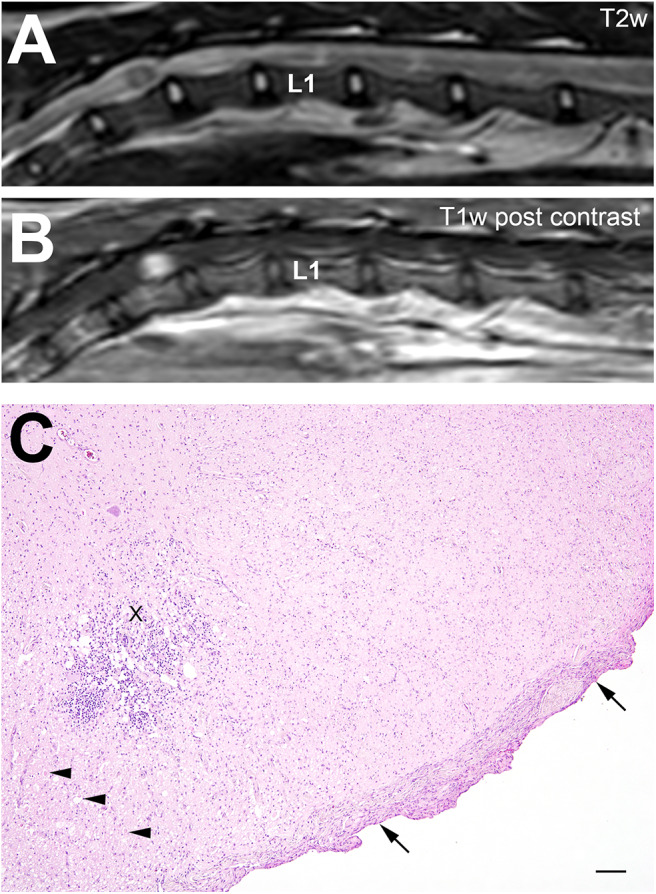
Cat no. 4. (A,B) Magnetic resonance imaging (MRI): Midsagittal section of the spinal cord at the thoracolumbar junction in T2w (A) and T1w post-contrast (B) sequences. First lumbar vertebra is marked with L1. Note the intramedullary hyperintense signal (A) from T11 to L1 and the focal contrast enhancement at the level of T12 (B). (C) Histopathology: Thoracic spinal cord showing a focally extensive severe lympho-histiocytic inflammation (X) associated with dilatation of myelin sheaths and swollen axons (arrowheads). In addition, a severe meningeal fibrosis is present (arrows). HE, bar = 100 μm.